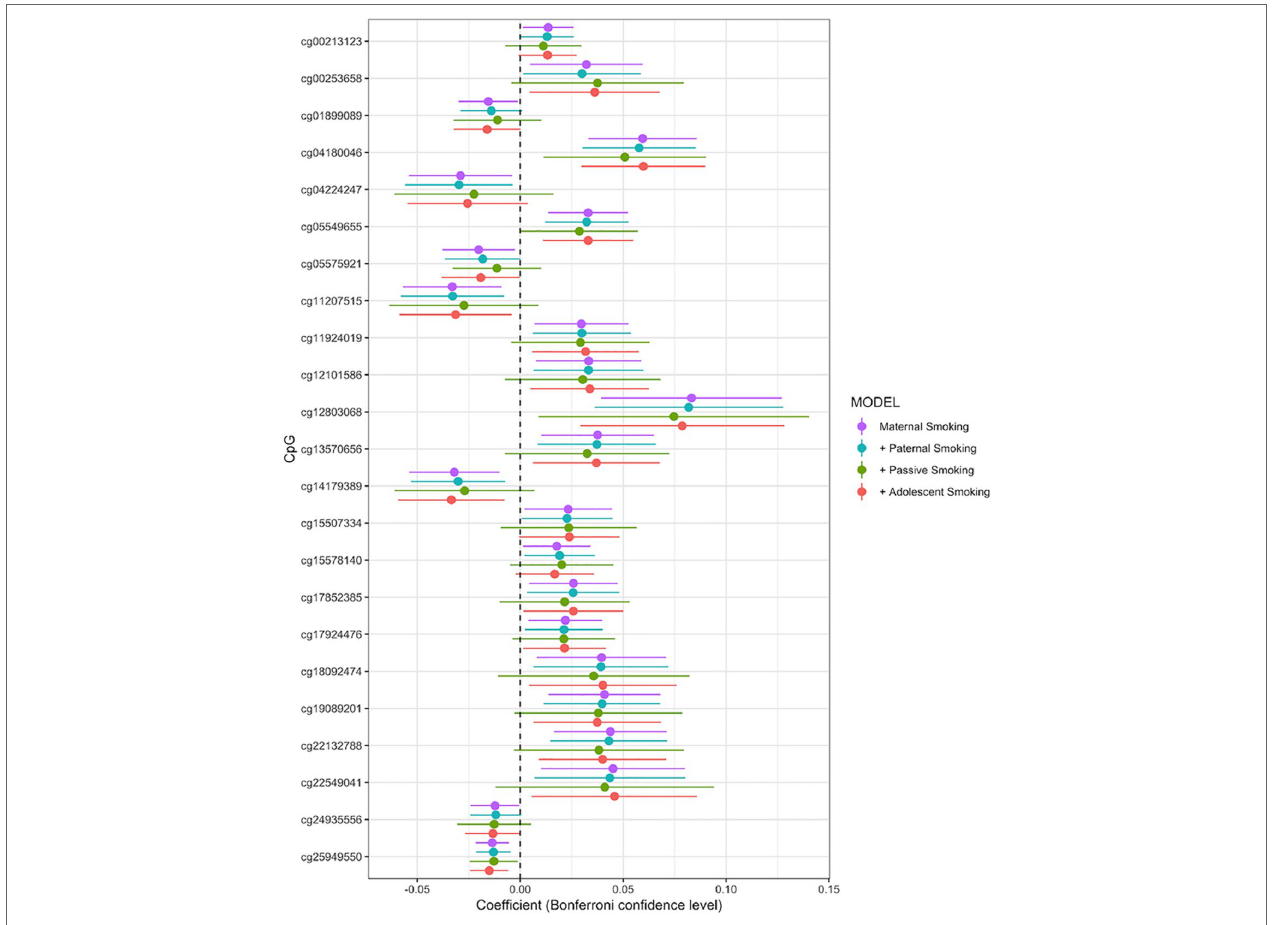
FIGURE 2 | Forrest plot for the epigenome-wide association study with maternal smoking as predictor and individual CpG sites as outcome, adjusted for sex, offspring age, age of the mother, birthweight, gestational weight gain, maternal alcohol consumption during pregnancy, maternal school level, maternal prepregnancy BMI, family income during pregnancy, cell count, and batch effects. Stratified by models without further adjustment ( n = 790), adjustment for paternal smoking ( n = 692), passive smoking ( n = 530), and adolescent smoking ( n = 663). X-axis : effect size from the linear mixed effects model and confidence interval; Y-axis : individual